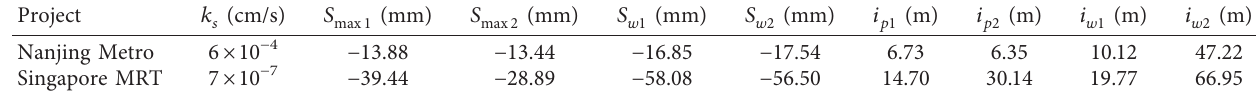
Table 4: Parameters of the simulation in Nanjing Metro and Singapore MRT.